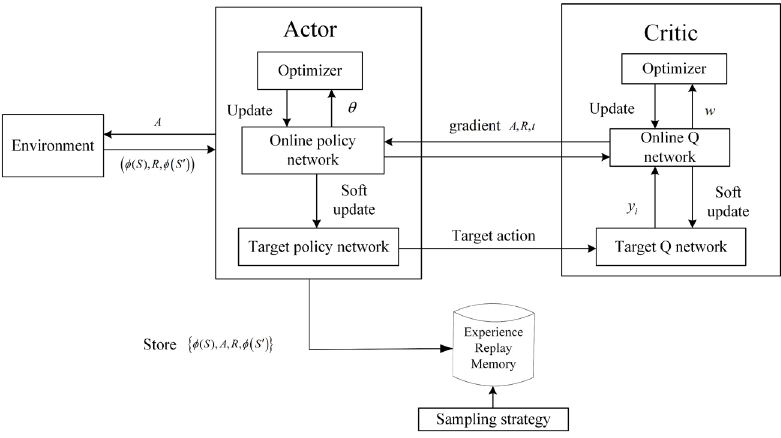
Figure 12. DDPG algorithm framework.